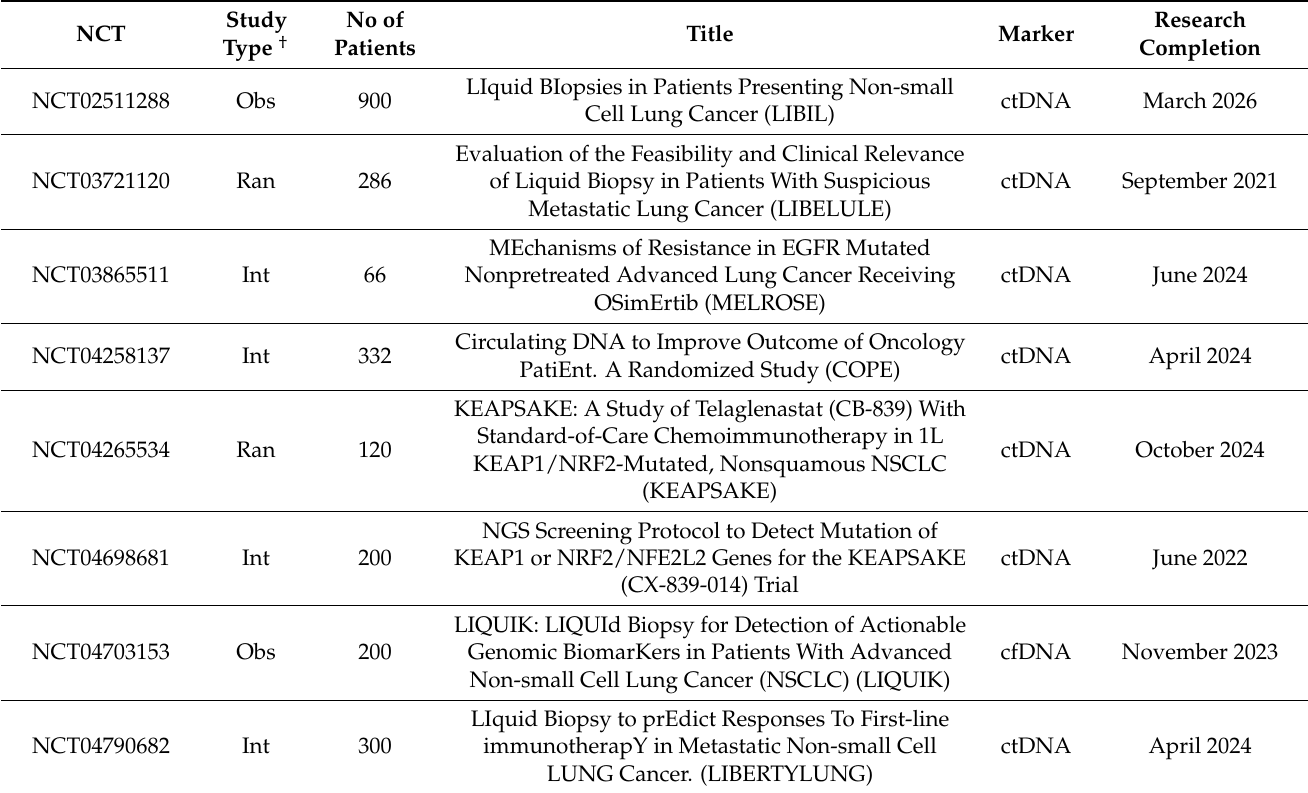
Table 2. Active clinical trials on liquid biopsy in advanced